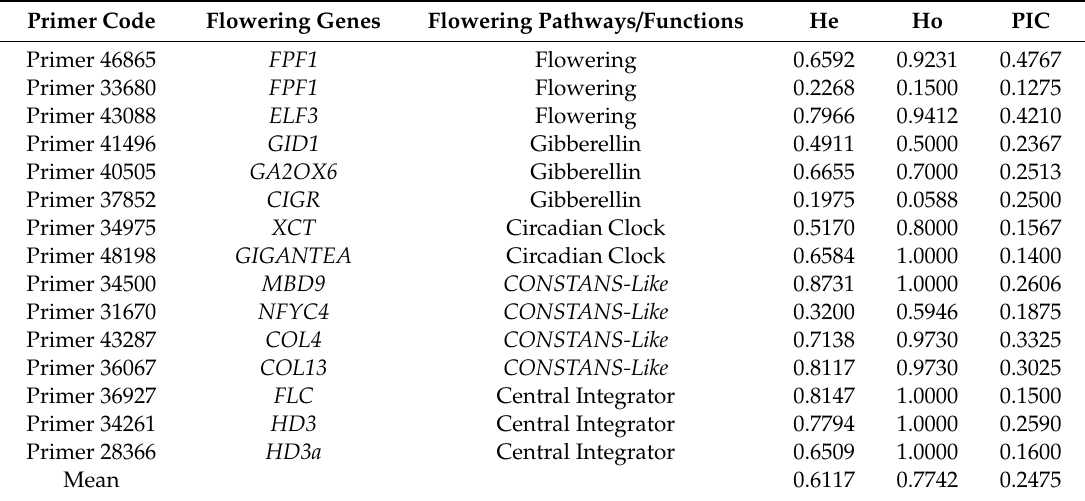
Table 2. He (gene diversity), Ho (heterozygosity), and PIC (polymorphic information content) of 15 polymorphic primers amplified in 20 E. sibiricus germplasms.